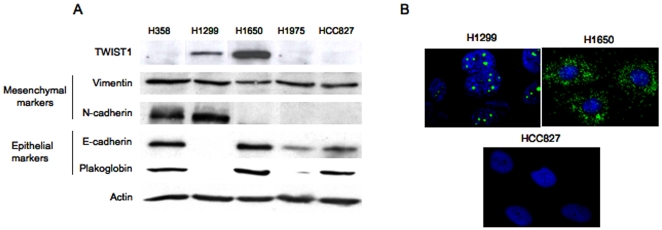
Basal expression of EMT markers in cell lines.
A. Assessment of TWIST1, Vimentin, N-Cadherin, E-Cadherin and Plakoglobin showing qualitative expression of markers by western blotting. B. Representative photomicrographs of TWIST1 expression in EGFR mutated cell lines (H1650 and HCC827) and in H1299 as assessed by immunofluorescence.